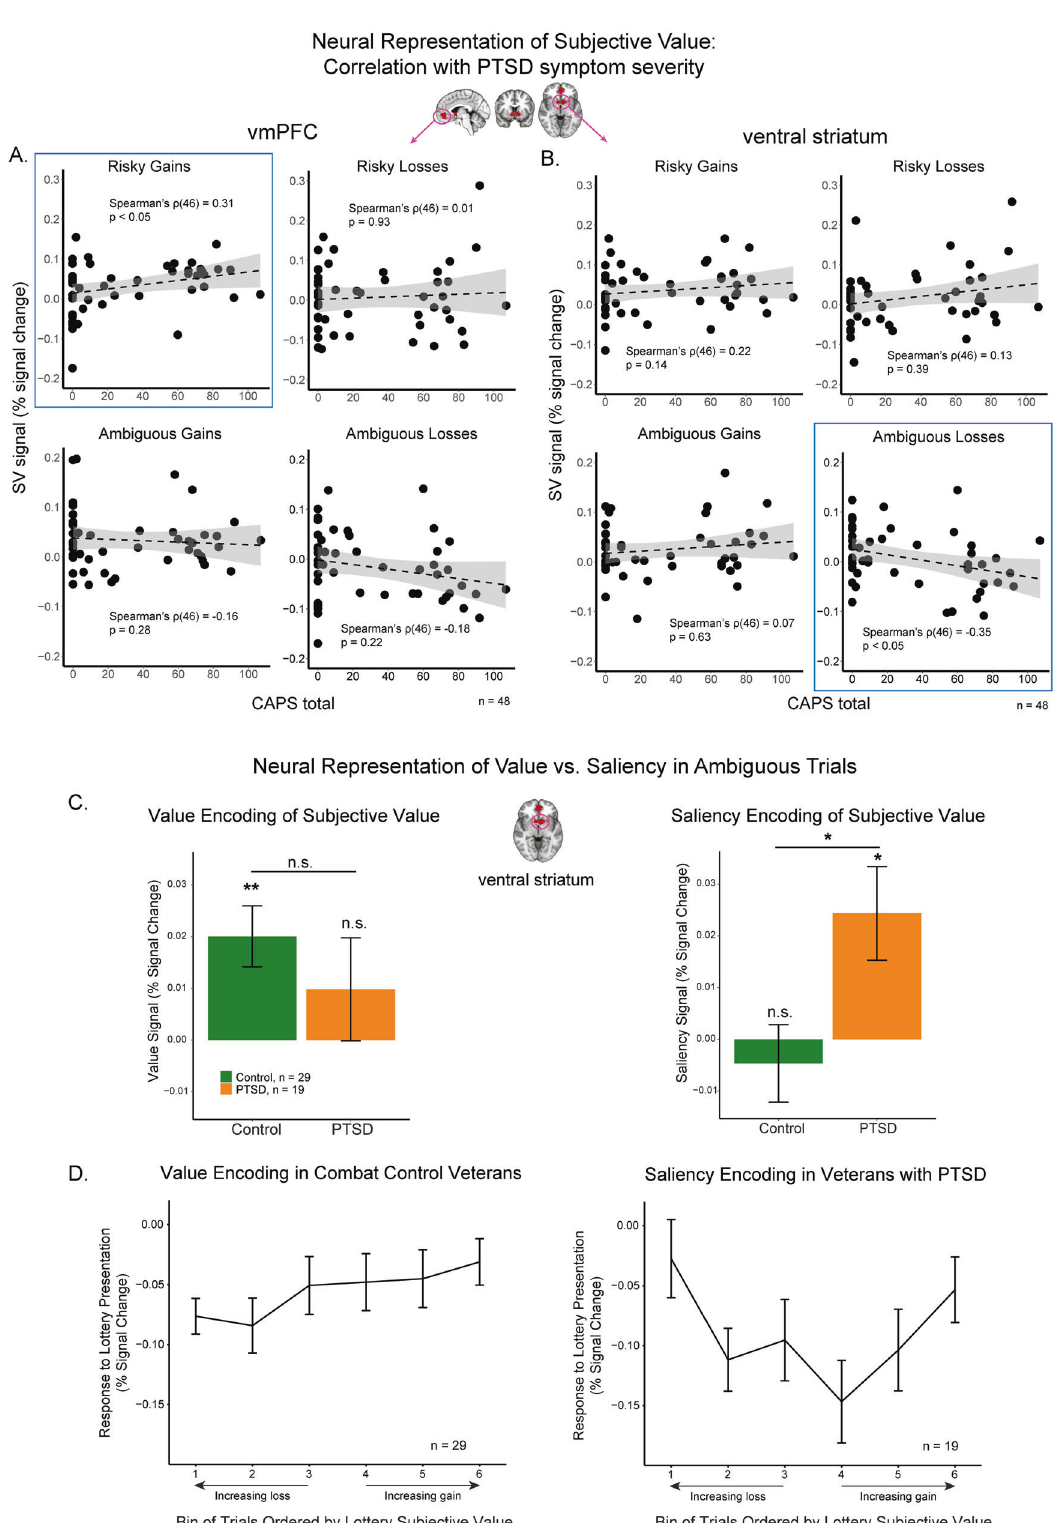
contributed to the negative association (standardized regression coef fi cient, Beta = − 0.72, t = − 2.32, p < 0.05, Fig. 3C). Age and intelligence did not signi fi cantly in fl uence vmPFC activity (Age: Beta = − 0.14, t = − 1.13, p = 0.26; intelligence: Beta = − 0.044, t = 0.33, p = 0.75). Variable selection using exhaustive search